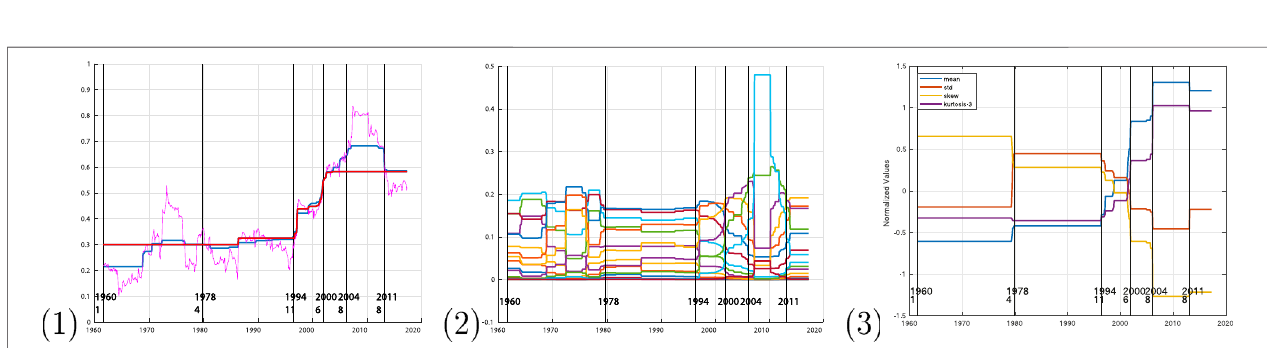
FIGURE 4 | Visualisation of the segmentations obtained starting from [1]: all 96 series R ij ( t ) (where we have represented two choices of the penalization parameter) [2];standardisedhistogramsofthesecorrelations(eachseriesbeingoneofthe21classes)or[3]indicators X ( t )=[ μ ( t ), σ ( t ), s ( t ), γ ( t )].Theverticalblackbarsshowthelimits of the periods proposed by the segmentation of the indicators [3] (note that the shift with the axes is only apparent: the data are centred in the middle of the 3-years windows, so the bar in 1978/4 is then almost displayed in 1980 since the 1980/01 window starts in 1978/7).